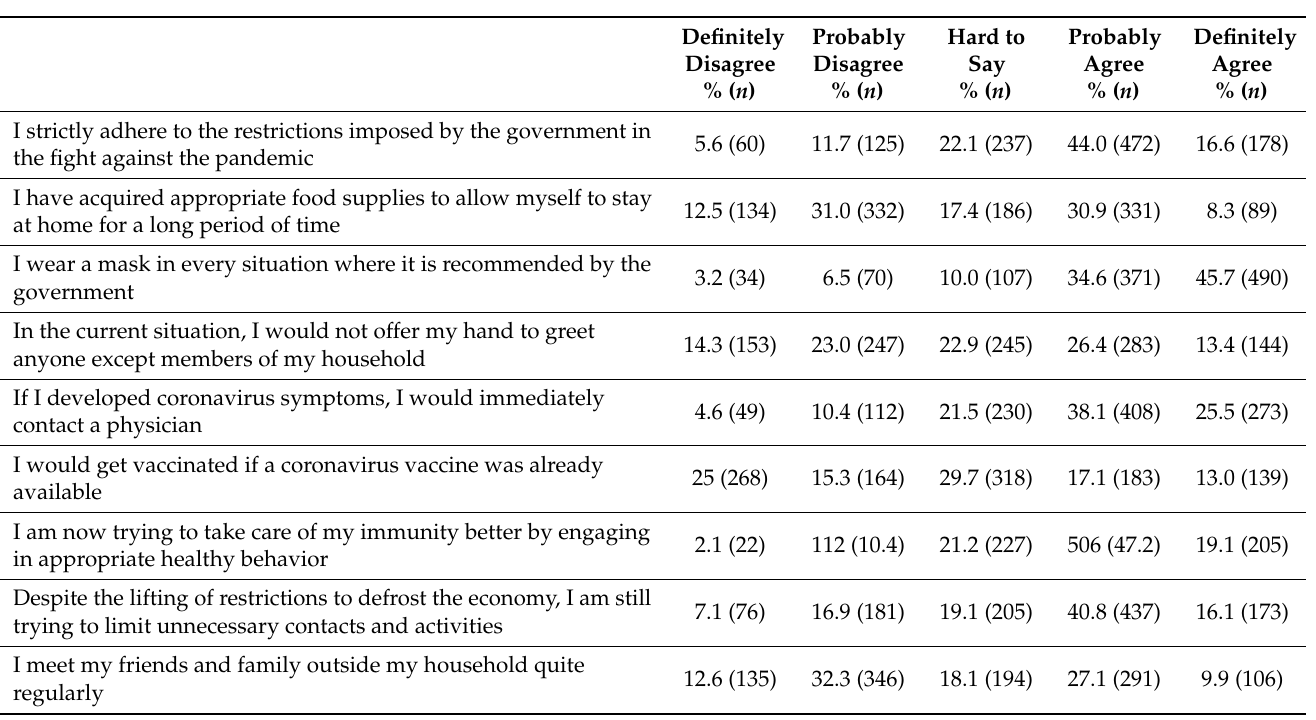
Table 3. Distribution of responses to statements used to create the recommended behaviors index ( n =